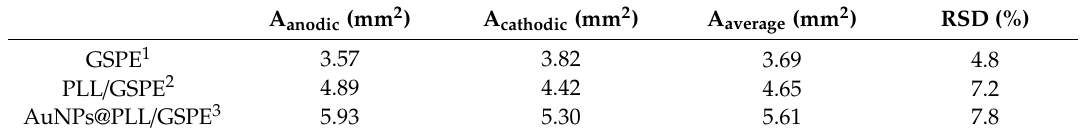
1 GSPE: Graphite screen-printed electrodes. 2 PLL / GSPE: Poly-L-lysine modified GSPE. 3 AuNPs@PLL / GSPE: Gold nanoparticles and PLL-modified